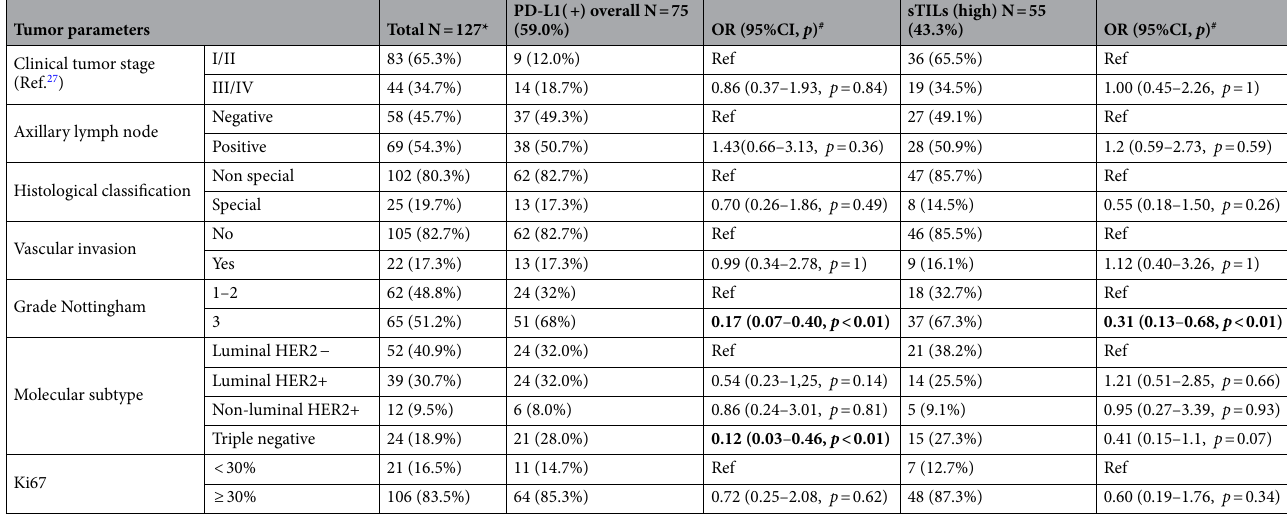
Table 2. Correlation between overall PD-L1 expression and high sTIL counts on diagnostic core needle biopsies and tumor parameters. Values in bold indicate data of statistical significance. *Three women had bilateral breast carcinoma; sTILs: stromal tumor infiltrating lymphocytes; Ref: reference value. In one case immunohistochemistry and FISH for HER2 was inconclusive. In ten cases HER2 was not expressed through immunohistochemistry and or FISH, in percutaneous needle core biopsies (pre-treatment specimens), and was positive in the surgical specimens after NACT (post-treatment specimens). The variables with significant association with PD-L1 in univariate analysis were selected to enter a multivariate regression model; after multivariate adjustment, triple negative remained significantly associated with PD-L1 expression ( p < 0.01; OR = 0.12, 95%CI 0.03 to 0.46). # p value calculation using Fisher’s exact test and logistic